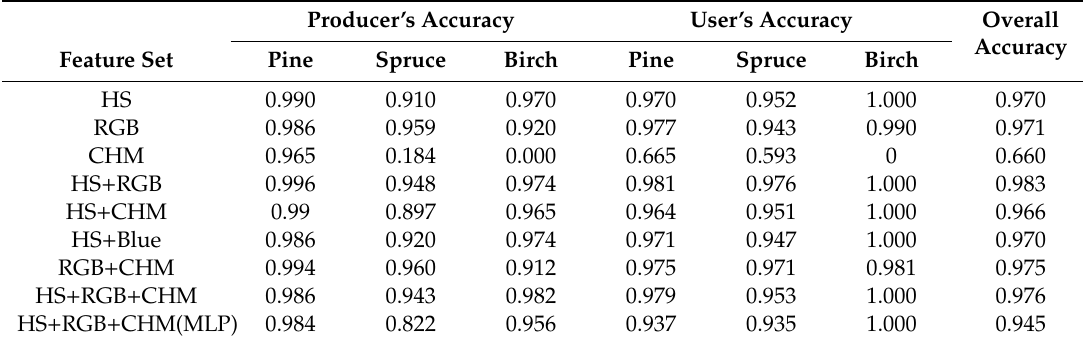
Table 3. Summary of the overall, producer’s, and user’s